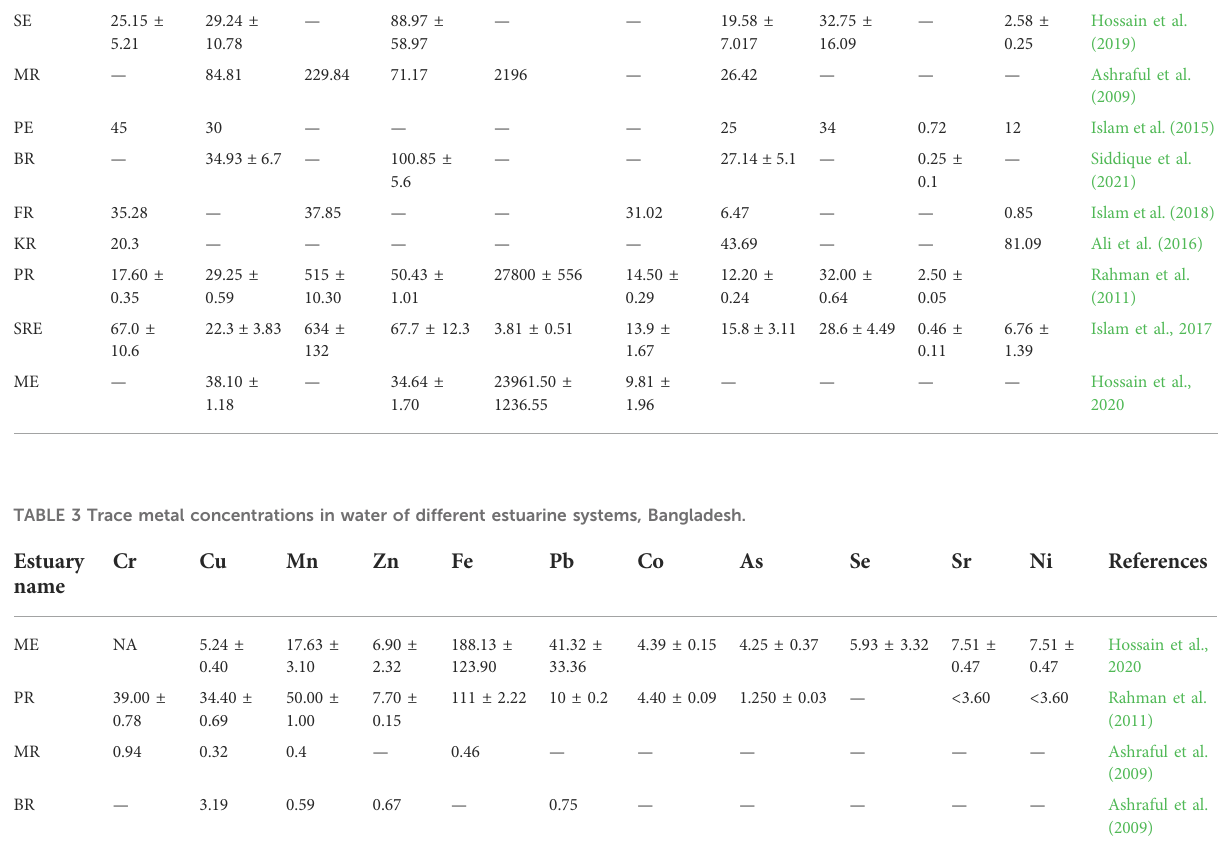
TABLE 2 Trace metal concentrations in sediment of different estuarine systems, Bangladesh. Estuary name